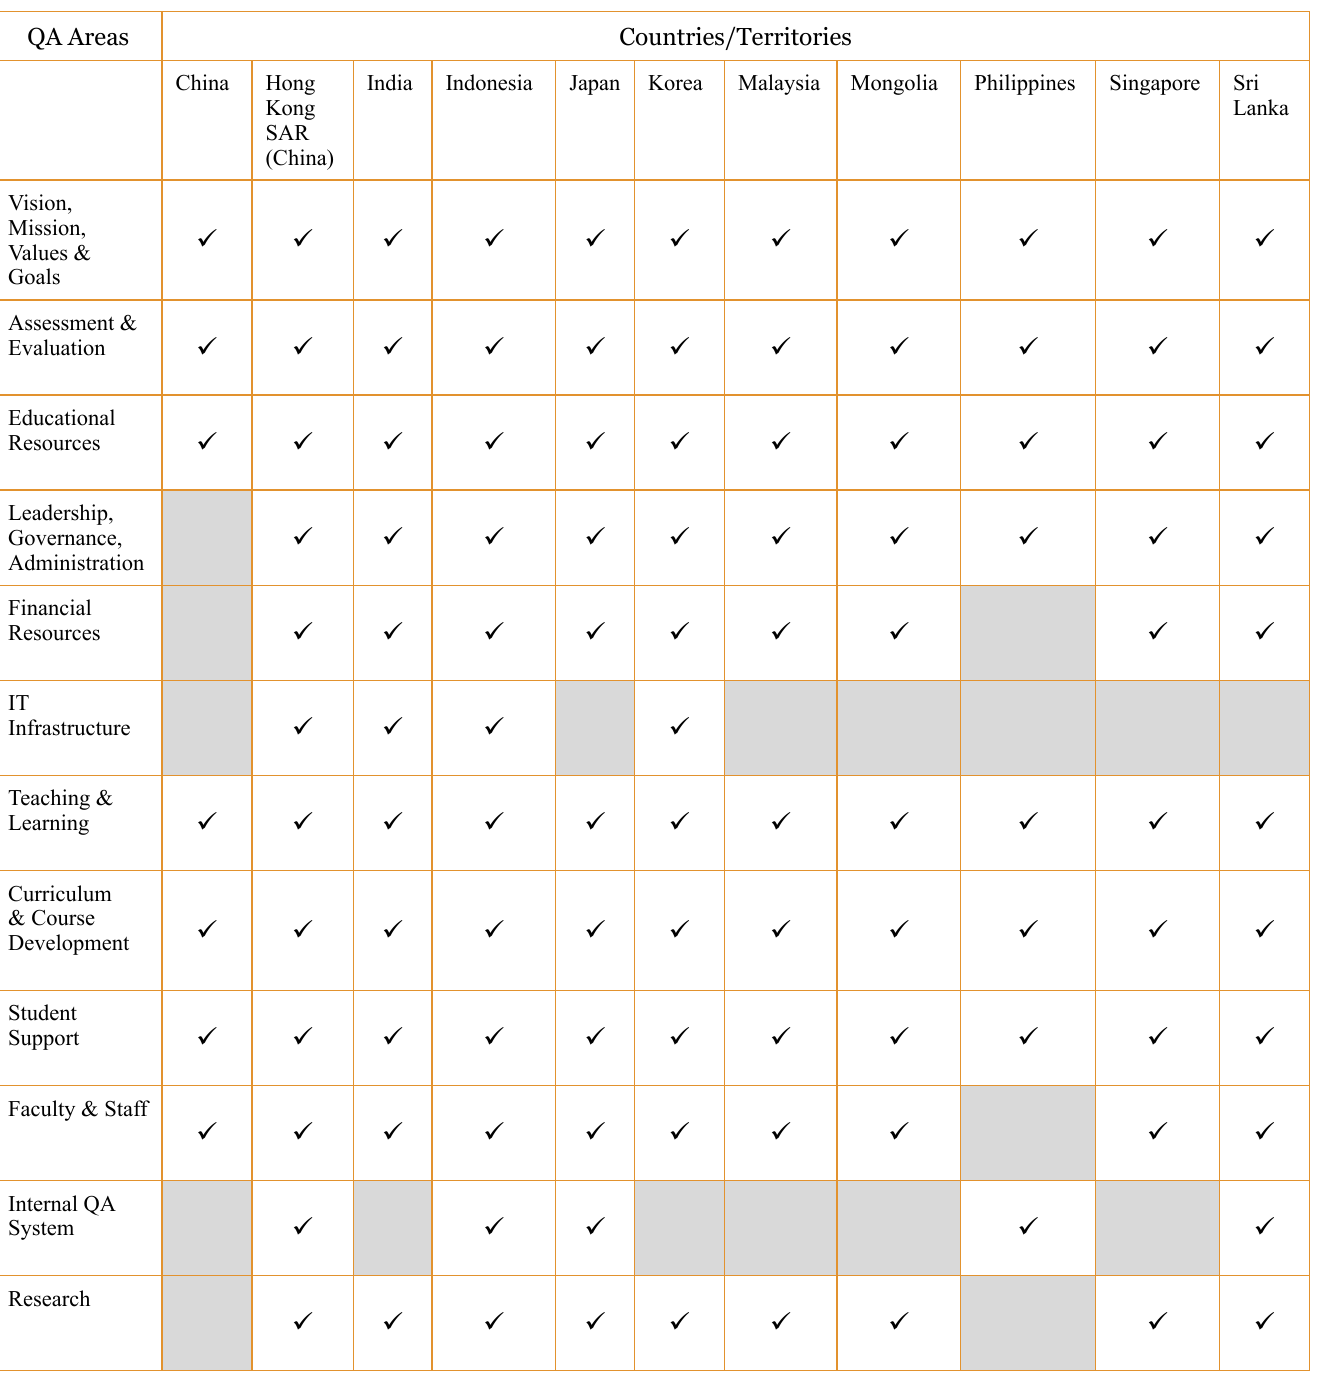
Table 2 Key QA Areas for DE in 11 Asian Countries/Territories QA